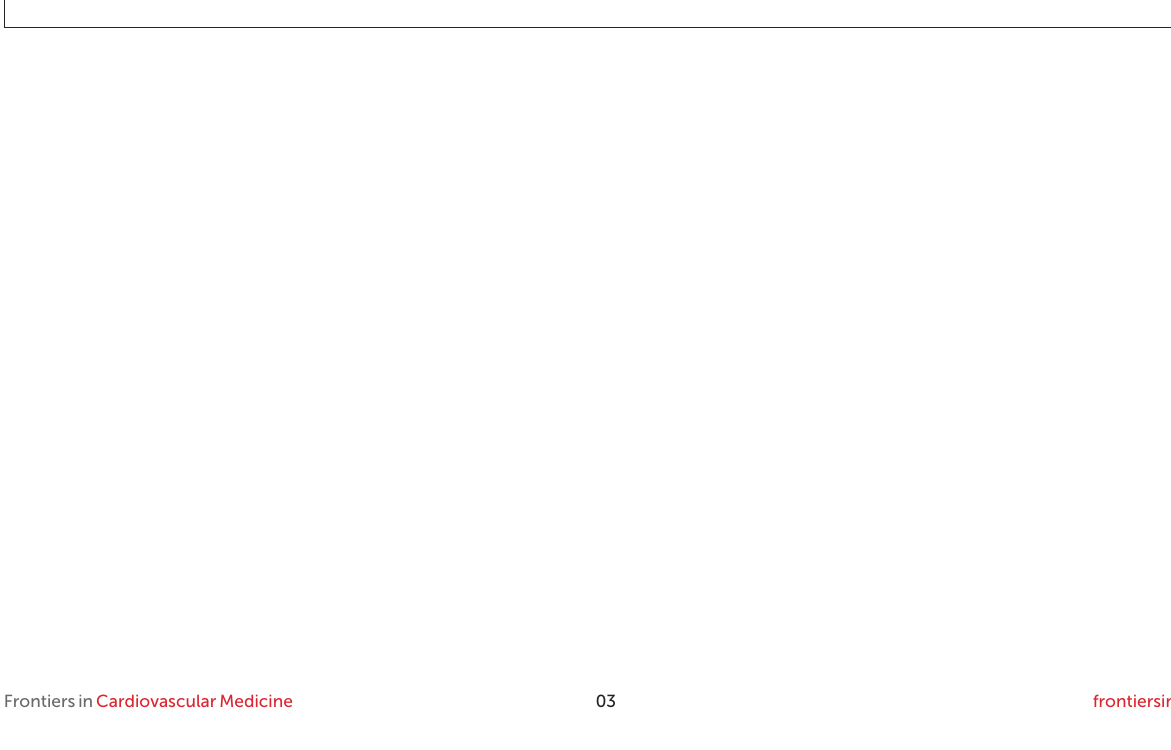
FIGURE4 (A) Red blood cell (before matching), p < 0.0001; (B) red blood cell (after matching), p = 0.0028; (C) platelet (before matching), p = 0.00017; (D) platelet (after matching), p = 0.072; (E) plasma (before matching), p < 0.0001; (F) plasma (after matching), p =